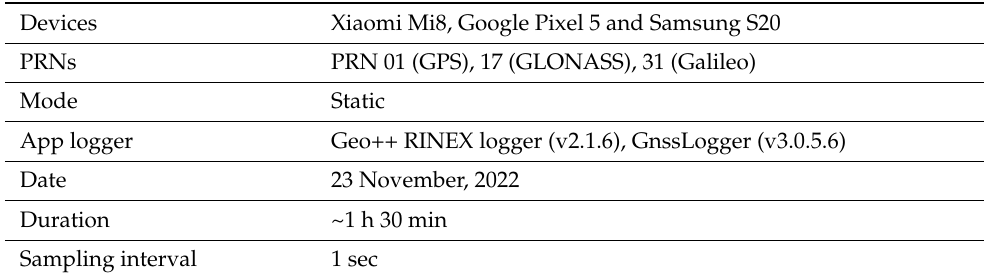
Table 2. GNSS data